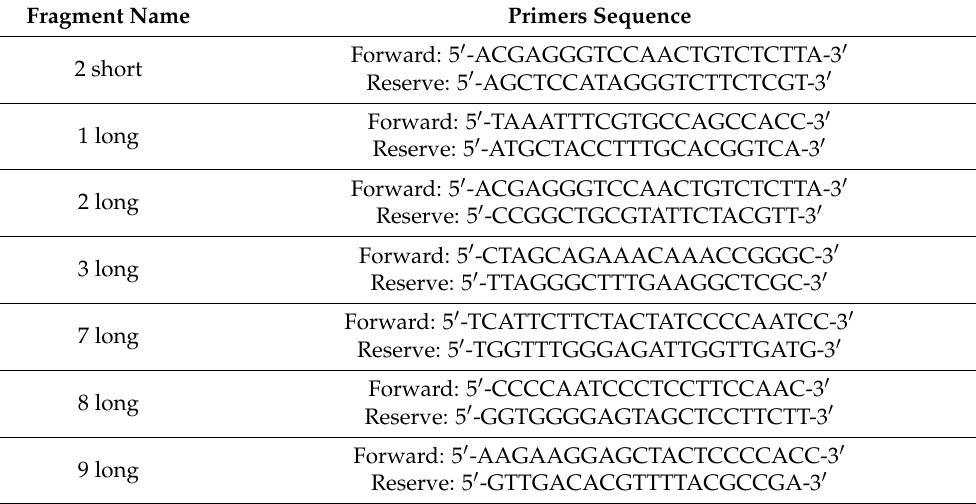
Table 1. Primers that were used to analyse measurement of mtDNA damage.